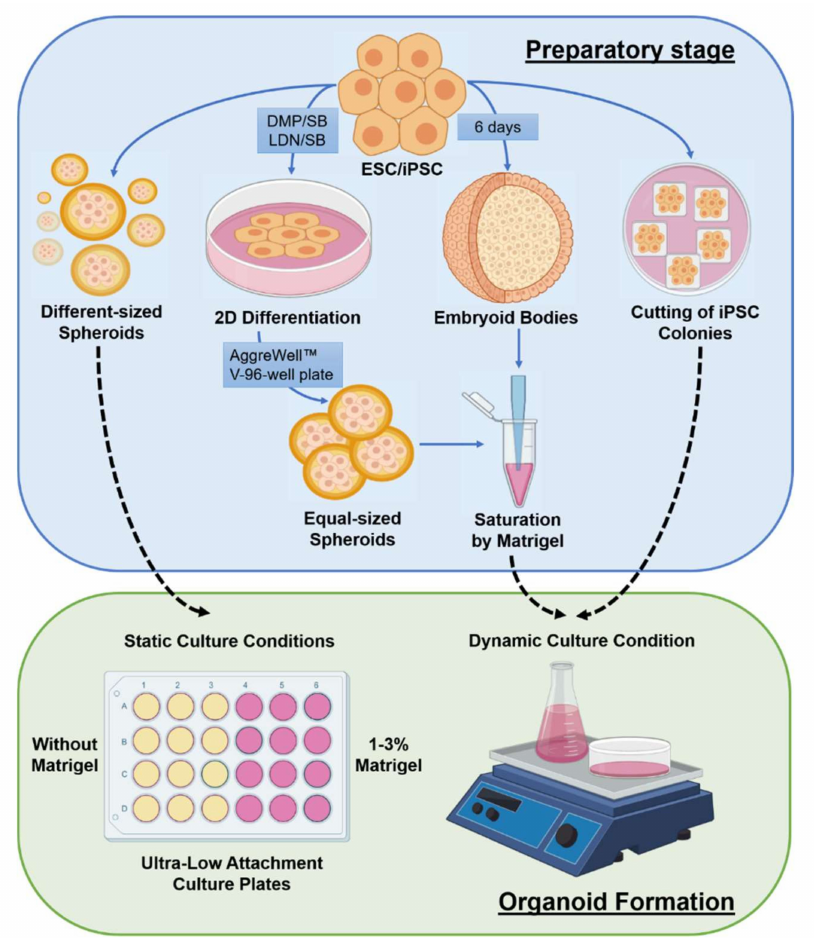
Figure 1. Basic strategies to produce cerebral organoids from PSCs. The preparatory stage includes various approaches for obtaining spheroids with or without preliminary differentiation into neuroep- ithelial progenitors. Then, the spheroids form cerebral organoids during long-term cultivation under stationary or dynamic culture conditions. DMP-dorsomorphin; SB- SB431542;